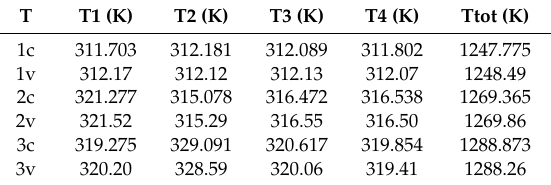
Table 5. Temperature of program calculation and simulation verification for optimized layout.